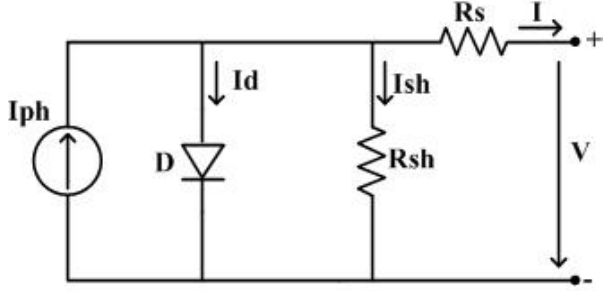
Figure 2. Equivalent circuit of a single-diode model of a PV cell.